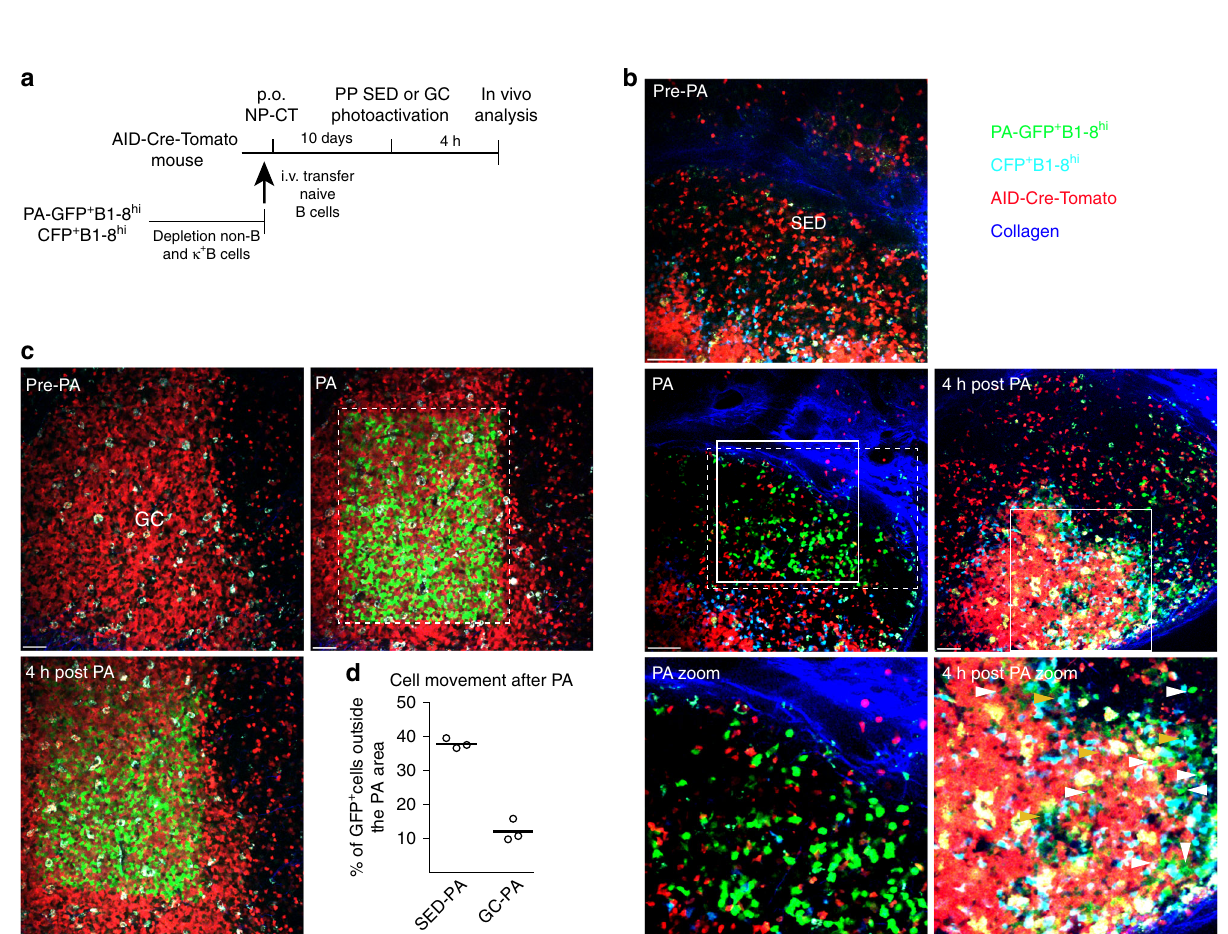
Fig. 5 Migration of activated NP-speci fi c B cells from the SED to GC regions of the Peyer ’ s patch following oral immunization. a Schematic representation of the model used to detect movements of B cells in the PP by photoactivation. B1 – 8 hi B cells expressing PA-GFP or CFP were adoptively transferred into AID Cre/ + Rosa26 fl -stop- fl tdTomato mice that were subsequently orally immunized with NP-CT. At 10 days after transfer, PPs were exposed and SED or GC areas were photoactivated based on CFP and tdTomato expression and the position of the photoactivated cells was subsequently analyzed 4 h later. b Photoactivation was guided to the SED region based on the presence of CFP + cells. Four hours after activation approximately 40% of the GFP + B cells had left the photo-converted area in SED. These were often found close to or within the GC at this point (marked with white arrowheads). In addition, macrophages were evident by auto- fl uorescence (marked with orange arrowheads; also see Supplementary Fig. 5a). c The GC was detected based on the large density of tdTomato + cells in the area. Four hours after photoactivation most of the PA-GFP + B cells remained within the GC area. d The percentage of B cells that had migrated from the photoactivated area within 4 h. The analysis represents one experiment performed on three distinct PP. Photoactivated areas are marked with dashed line rectangles and close up areas with normal line quadrants. Similar results were obtained in 3 independent experiments. Scale bar = 80 µ m. Source data are provided as a Source Data fi